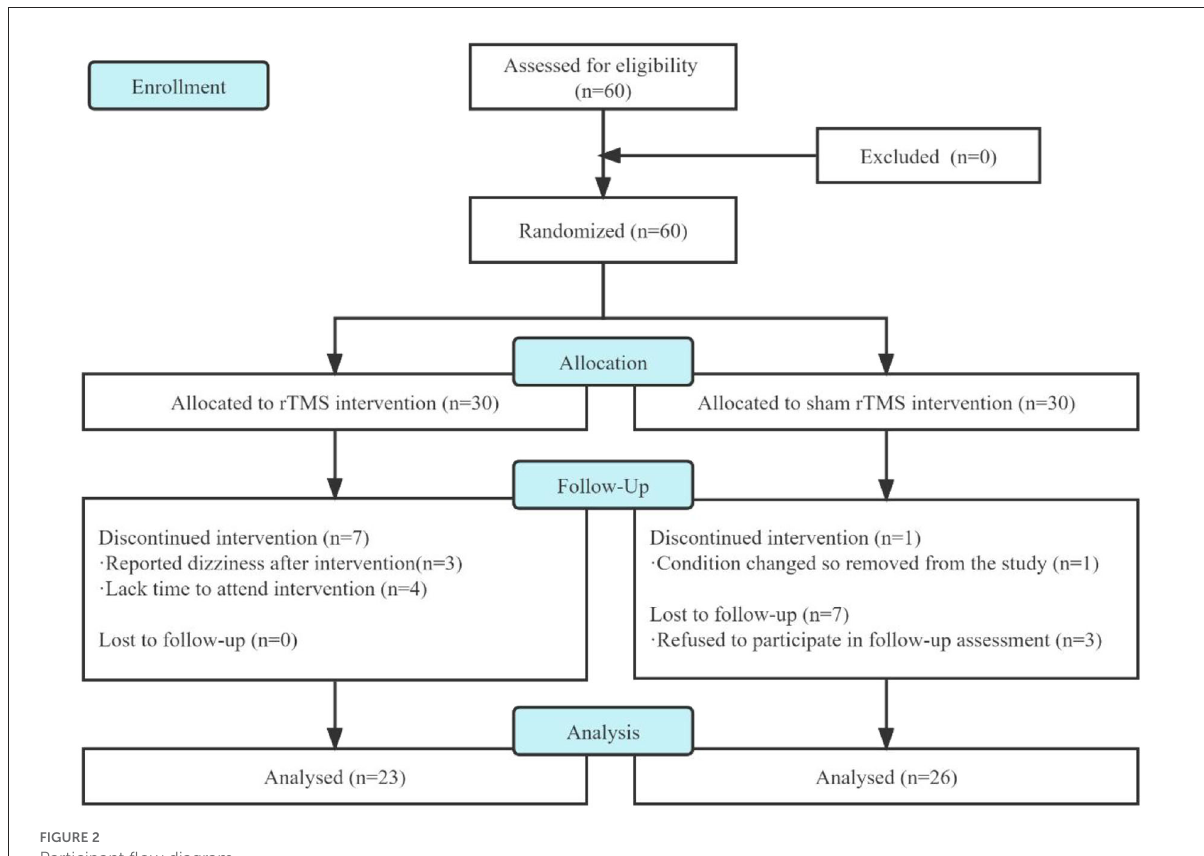
FIGURE2 Participant flow